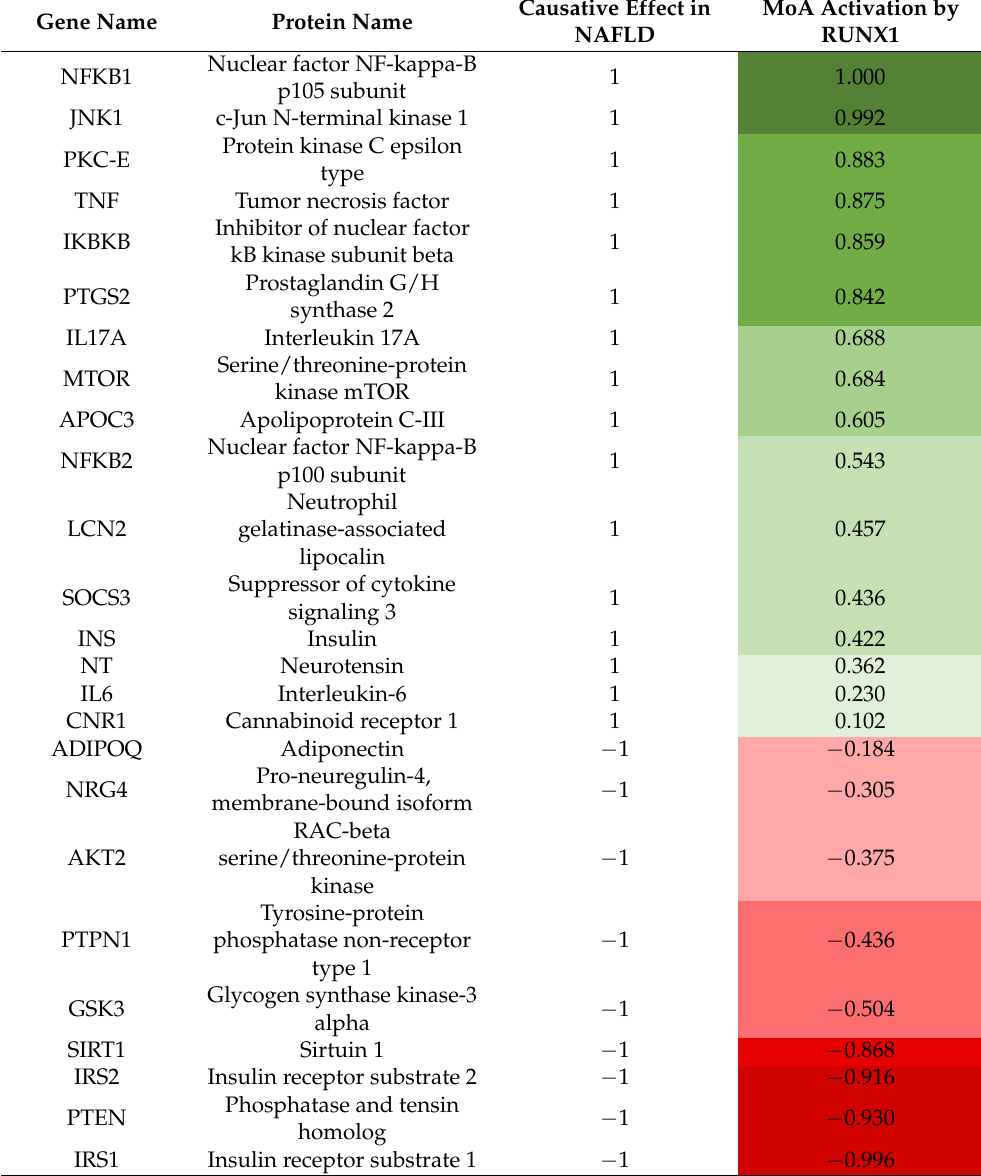
Table 2. IR effector proteins modulated by RUNX1 activation. Causative effect indicates whether the protein is increased/overactivated (1) or reduced/inhibited (–1) in